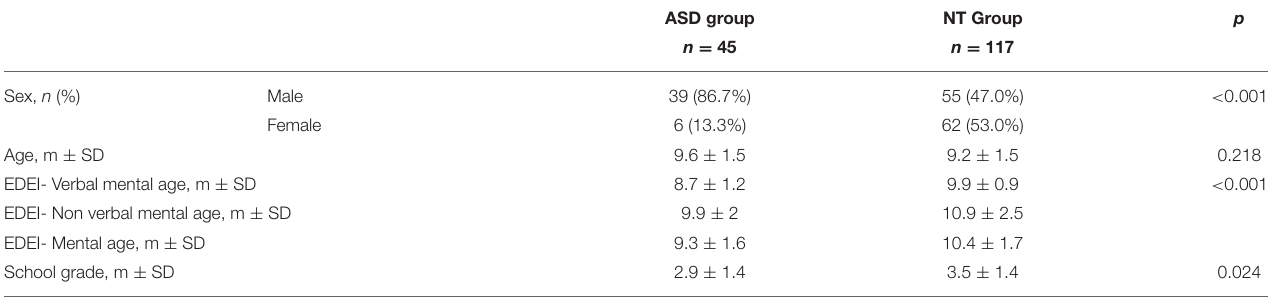
TABLE 1 | General characteristics of the autism spectrum disorder group vs. the neurotypical